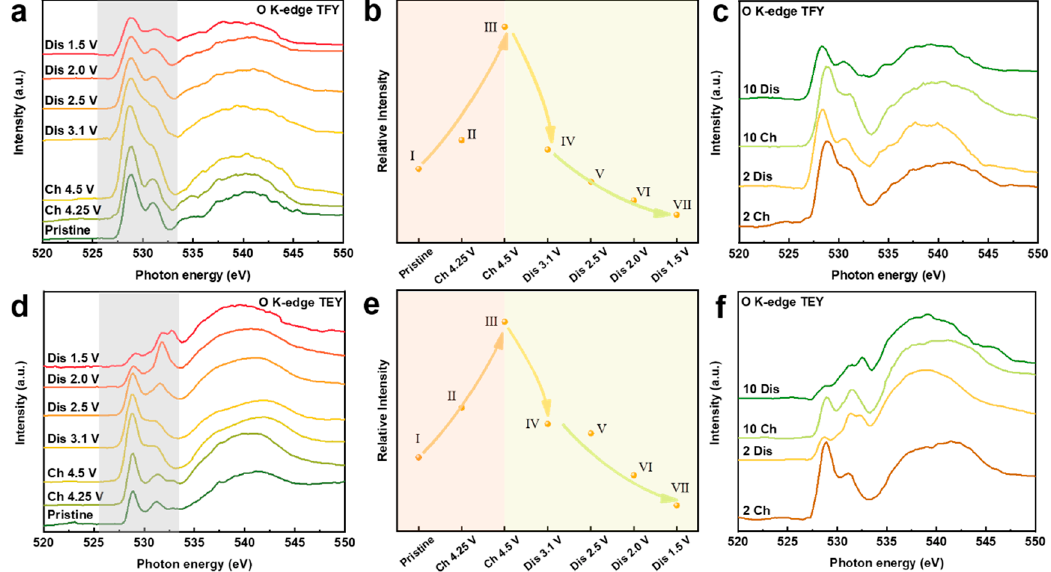
Figure 6. ( a , d ) O K-edge XAS spectra of NaMMO electrodes at different SOCs during the initial cycle in TEY and TFY modes, respectively. ( b , e ) The intensities of the pre-edge features at different SOCs during the initial cycle in TEY and TFY modes, respectively. ( c , f ) The O K-edge XAS spectra of NaMMO electrodes at fully charged/discharged states after 2 and 10 cycles in TEY and TFY modes, respectively.